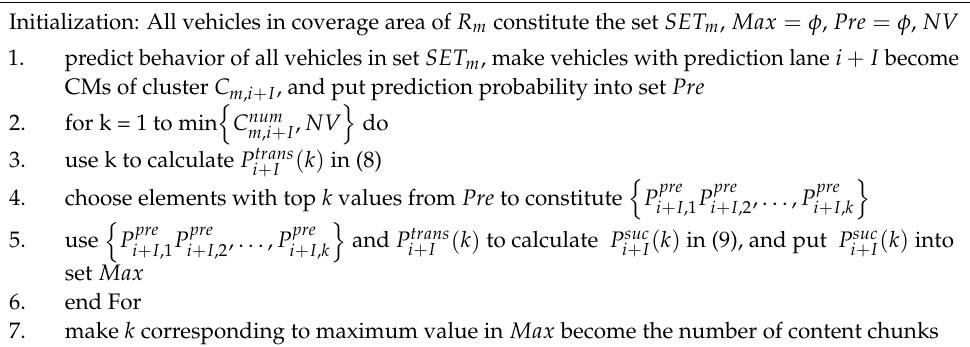
Algorithm 2 Caching Algorithm for Optimizing the Number of Content